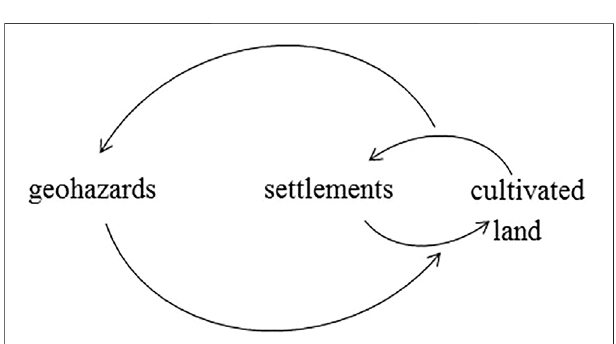
FIGURE 8 | The coupling mechanism of geohazards, settlements, and cultivated